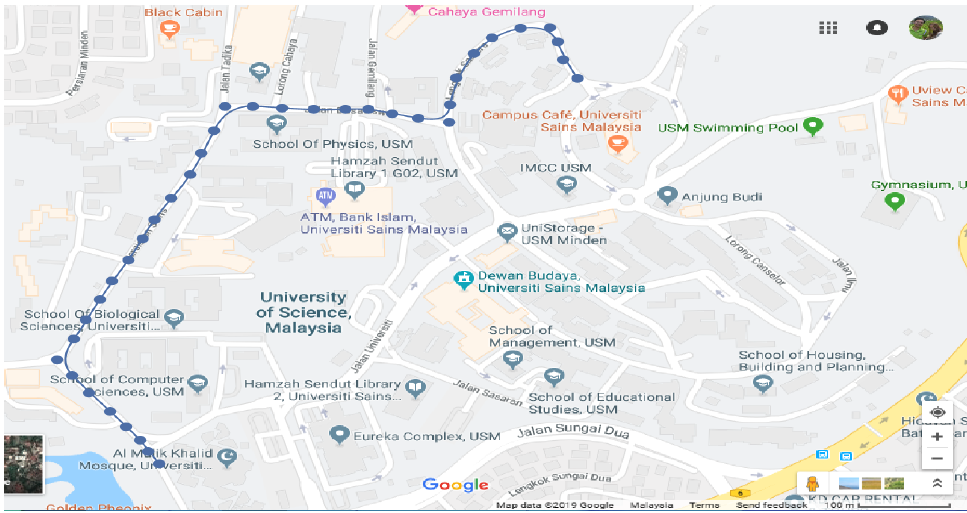
Figure 13. USM Route Curve Constructed with Hermite Interpolation Curve.